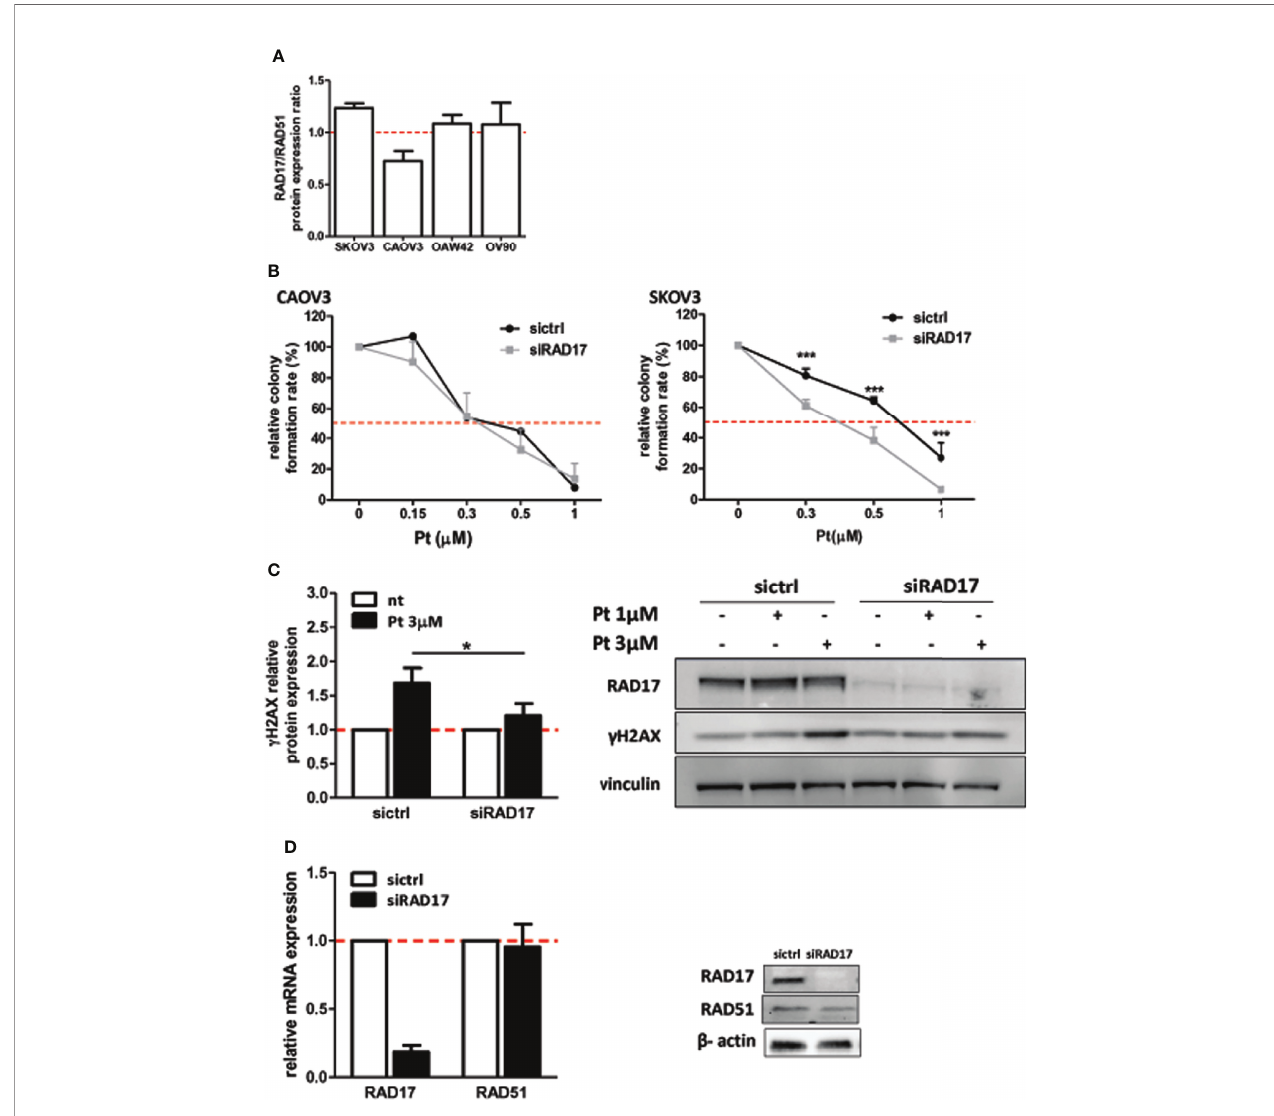
FIGURE 3 | RAD17 silencing increased sensitivity to Pt-treatment in EOC in-vitro model. (A) Relative expression of RAD17 and RAD51 proteins as de fi ned by Western Blotting on the panel of cellular models used. Bars represent the ratio of RAD17/RAD51. (B) Clonogenic assays of CAOV3 (left panel) and SKOV3 (right panel) cell lines silenced with siRNA targeting RAD17 (siRAD17) or with a control siRNA (siCTRL) and treated with Pt at the indicated doses. Percentages of relative colony formation rate of siRAD17 versus siCTRL transfected cells are reported. Two way ANOVA and Bonferroni ’ s post test was used to compare groups (*** p<0.001). (C) Western blot analysis of g H2AX expression in SKOV3 cells silenced for RAD17 and treated with 1 and 3 µM Pt. Vinculin was used as loading control. Left panel : Bars represent the ratio of g H2AX expression (normalized on vinculin) between Pt-treated and untreated cells. Data are mean ± SD of at least three experiments. Student ’ s t test was used to compare siRAD17 cells versus sictrl transfected cells (*p<0.05); right panel : representative western blot. (D) Effects of RAD17 silencing on RAD17 and RAD51 mRNA (left panel) and protein (right panel) expression